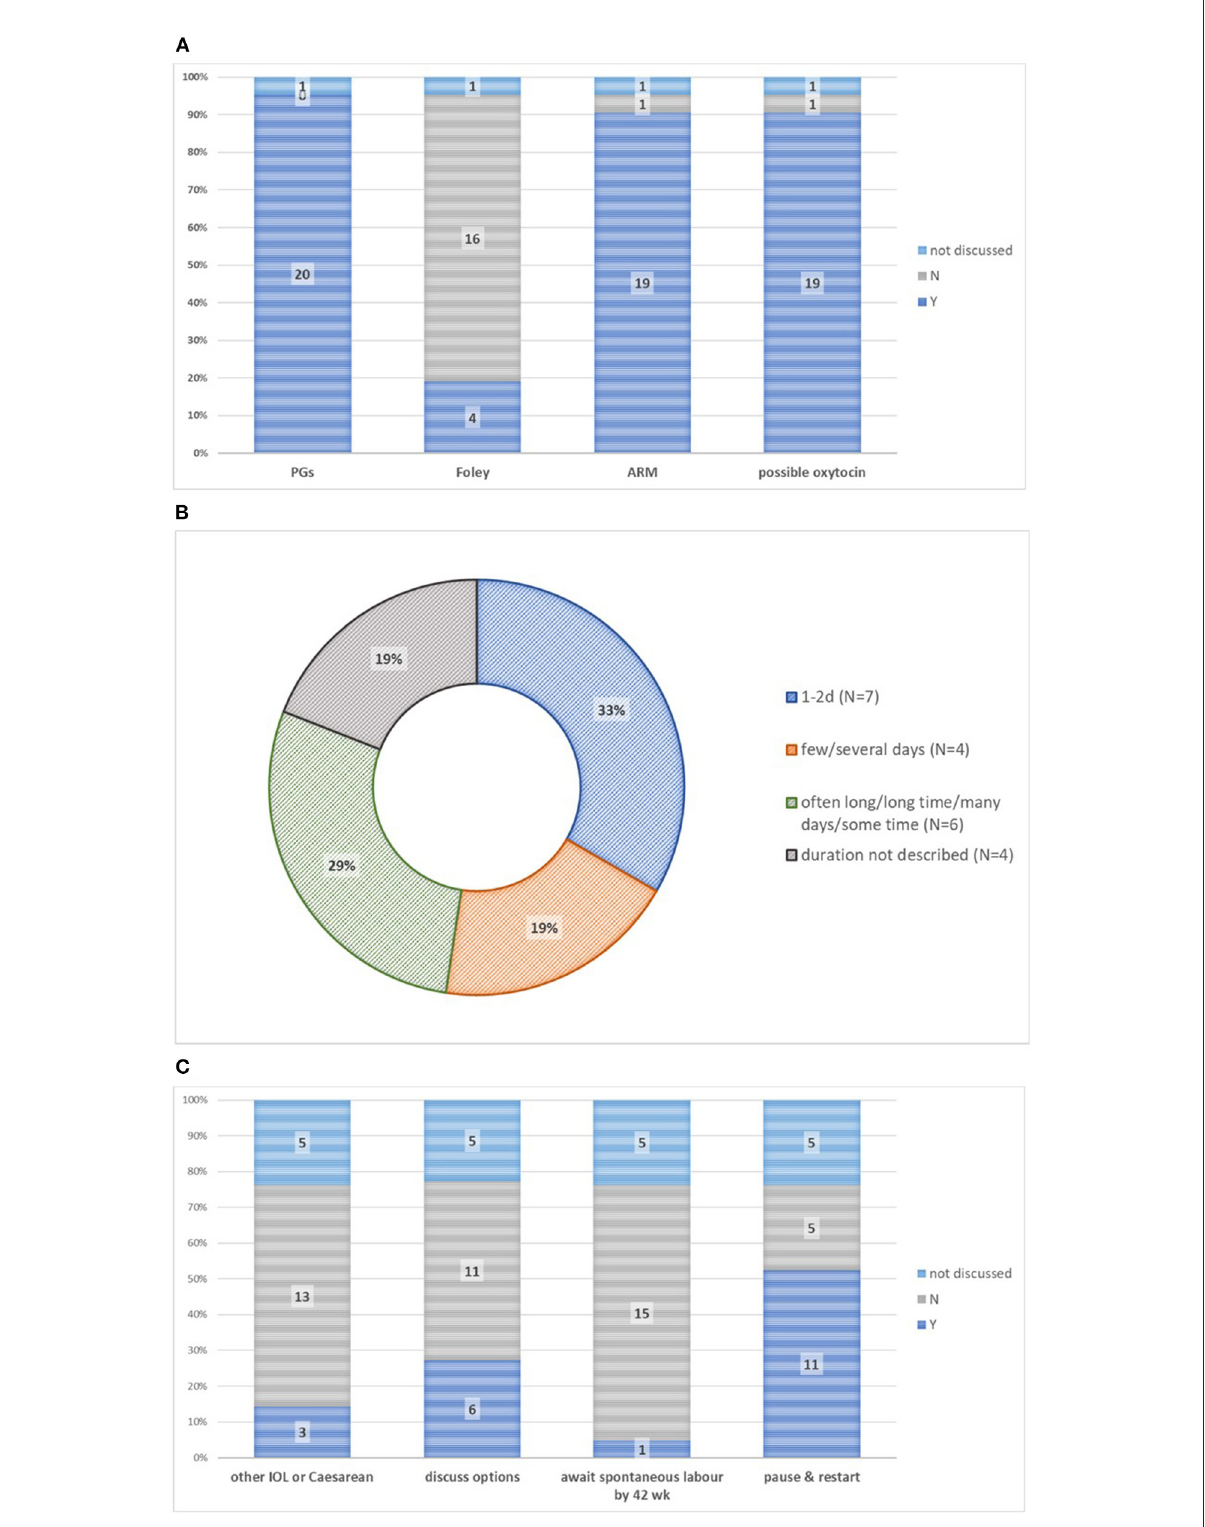
FIGURE3 Process of induction in 21 patient information leaflets. (A) Methods of induction. (B) Time to onset of labor or birth. (C) Options if induction initially unsuccessful. ARM, artificial rupture of membranes; PGs, prostaglandin E 2 -based intervention; IOL, induction of labour.